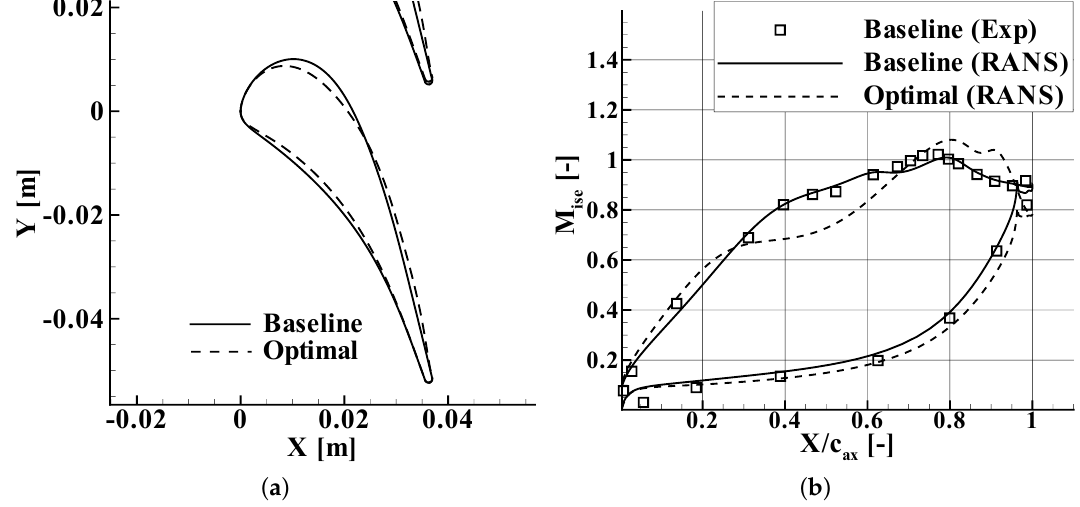
Figure 4. Baseline and optimal profiles and isentropic Mach number comparison. ( a ) Baseline and optimal profiles; ( b ) Isentropic Mach number ( M ise ) comparison versus the axial chord ( c ax ) non-dimensionalized